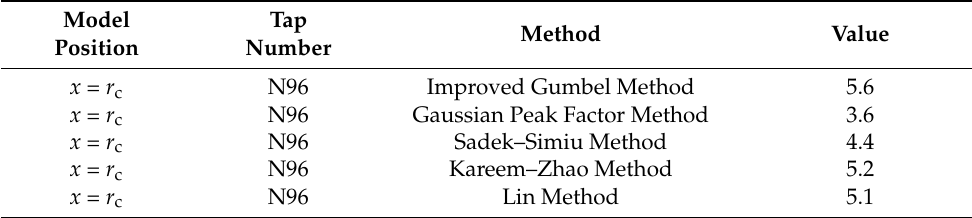
Table 5. Summary of peak factors obtained by different